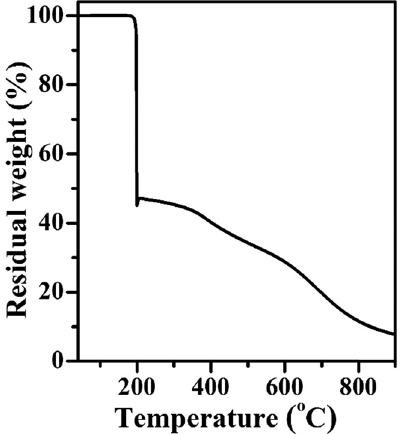
Figure A4: The TGA pro fi le of TMZ ( heating rate: 10°C · min − 1 ) . When compared with TMZ itself, the decomposition temperature of TMZ in CTF – TMZ was relatively higher because TMZ was loaded in the CTF ’ s